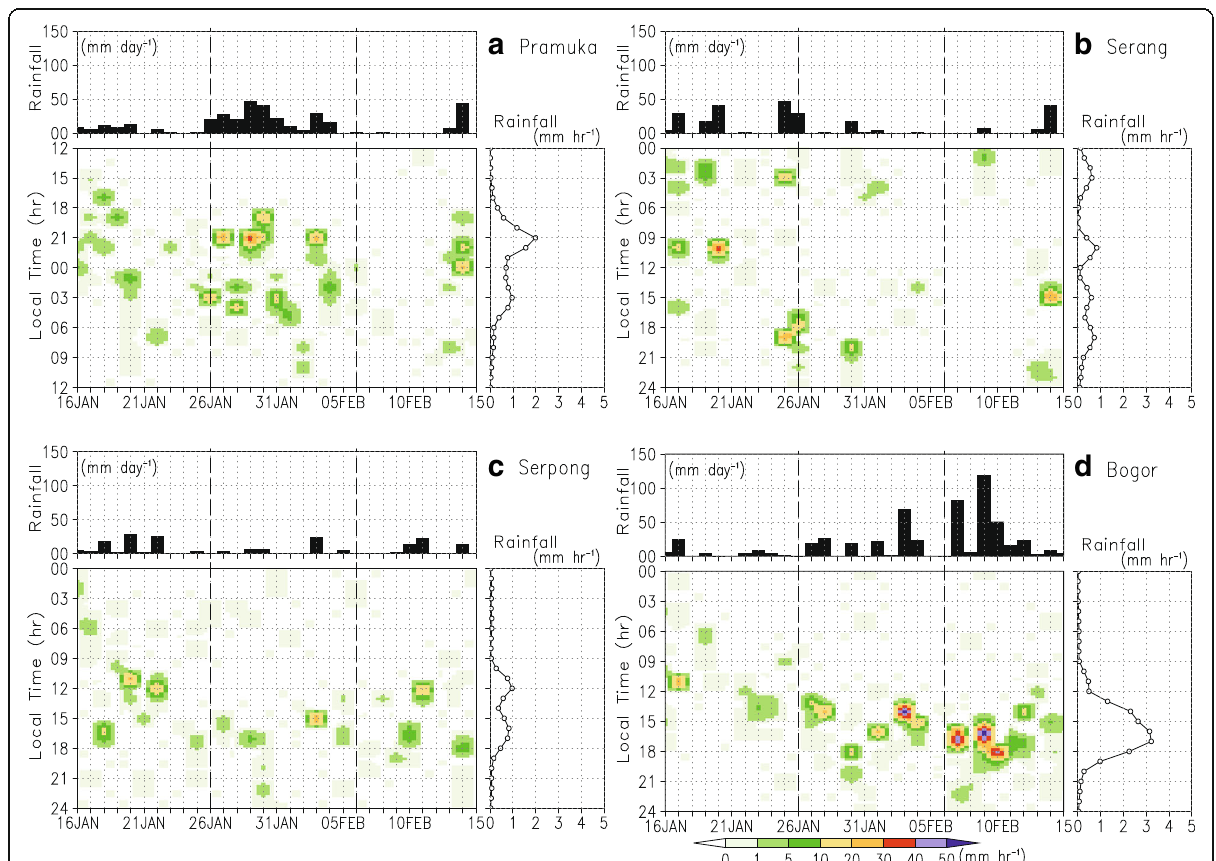
Fig. 5 Surface rainfall data obtained by AWSs during the campaign period. Daily and diurnal variations of the surface rainfall observed by AWSs during the campaign period: a Pramuka, b Serang, c Serpong, and d Bogor. Top and side panels for each site indicate the daily rainfall amount and period averaged rainfall diurnal variation, respectively. Note that the time in the bottom panel only at Pramuka ( a ) runs downward from 12 LT to 12 LT on the following